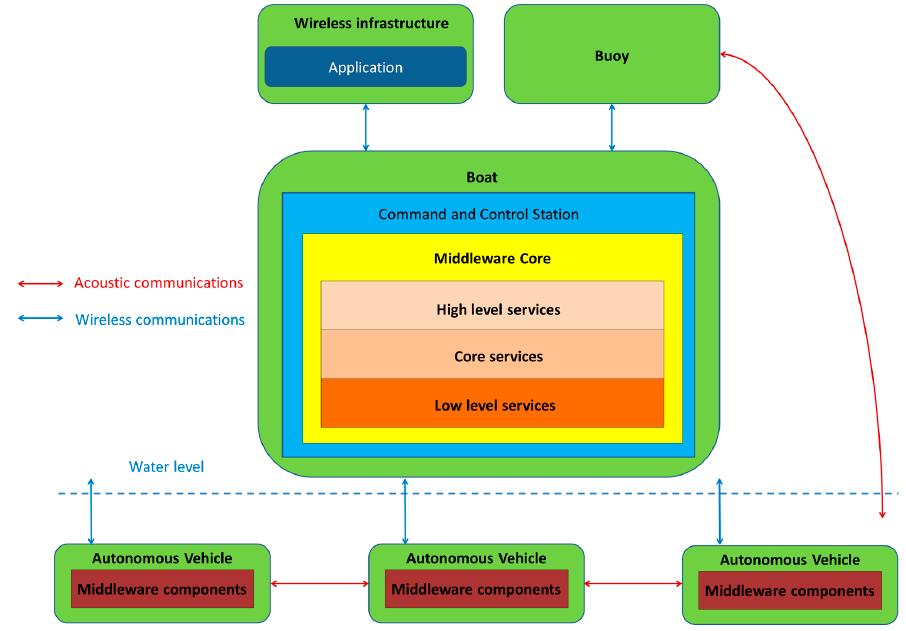
Figure 1. Distribution of middleware. MDTP is used over the acoustic and wireless network.